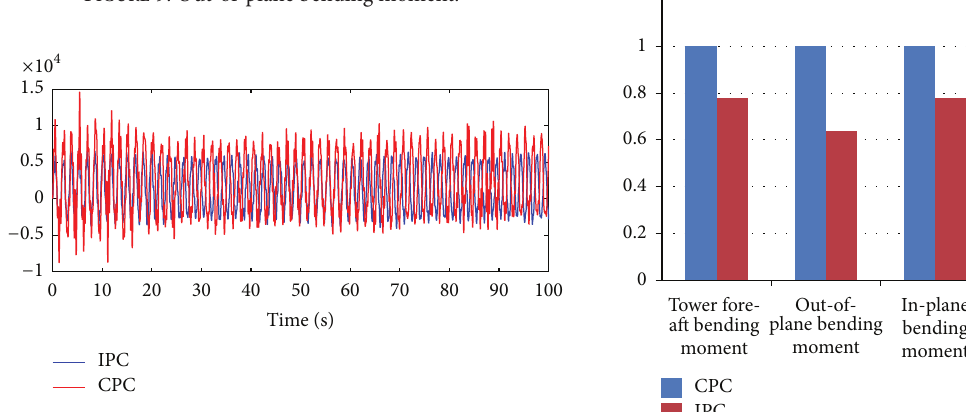
Figure 9: Out-of-plane bending moment.